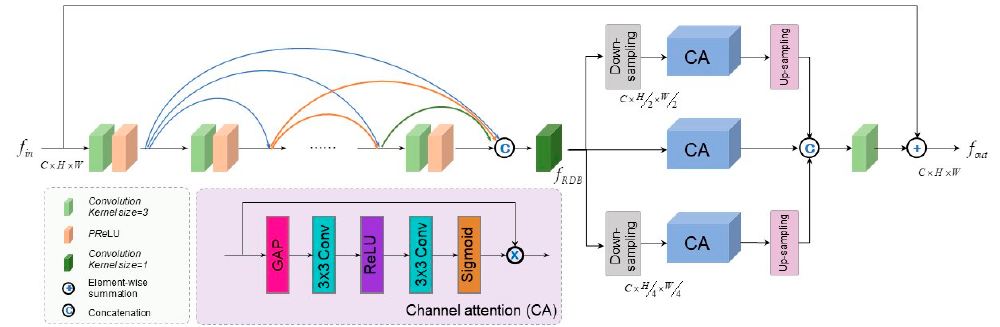
Figure 3. Illustration of the MSARDM in the TCSLB.